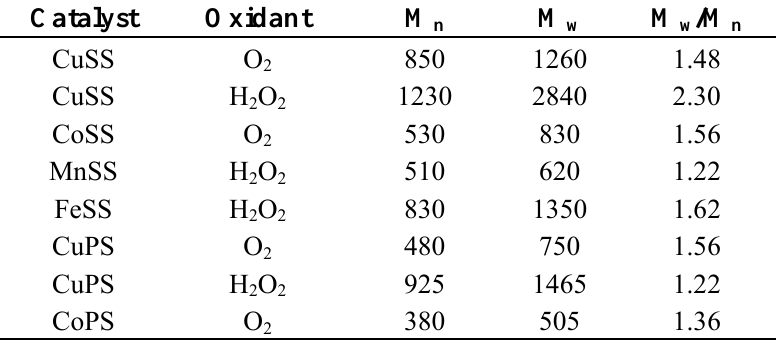
Table 1. Results of GPC analyses on oxidation products of isoeugenol with different